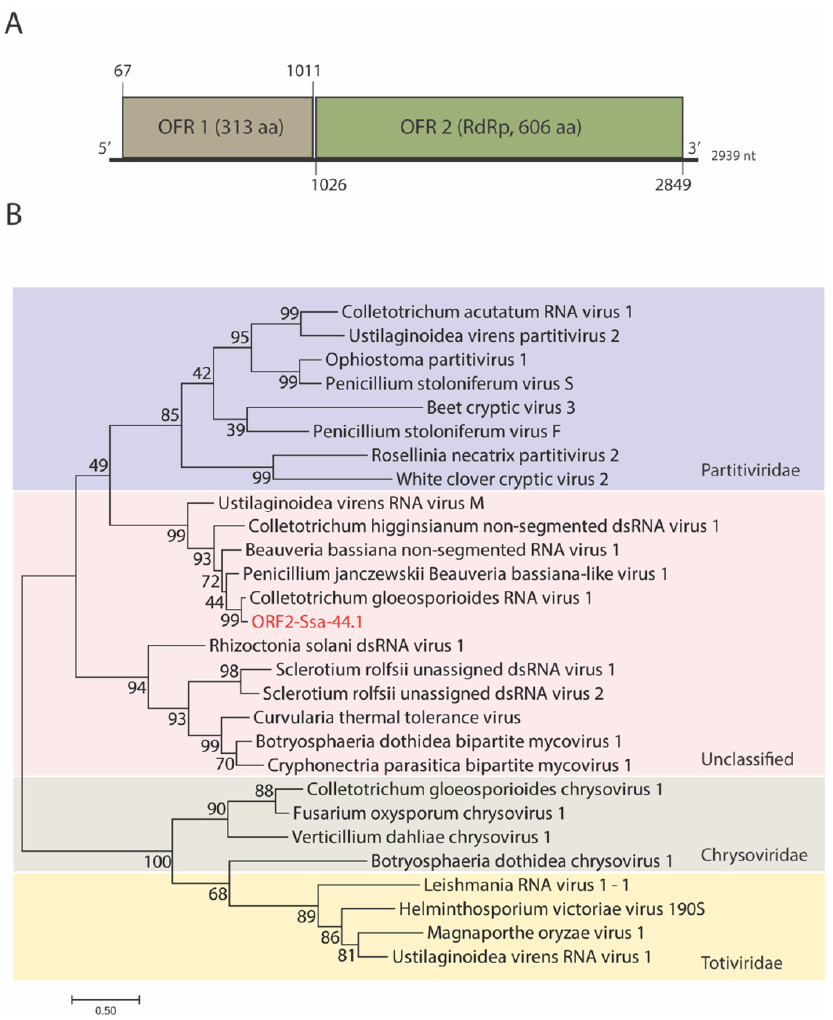
Figure 2. Schematic representation of mycovirus genome strain Ssa-44.1 and phylogenetic analysis, ( A ) The genetic organization of mycovirus Ssa-44.1 is depicted in this illustration. The genome of